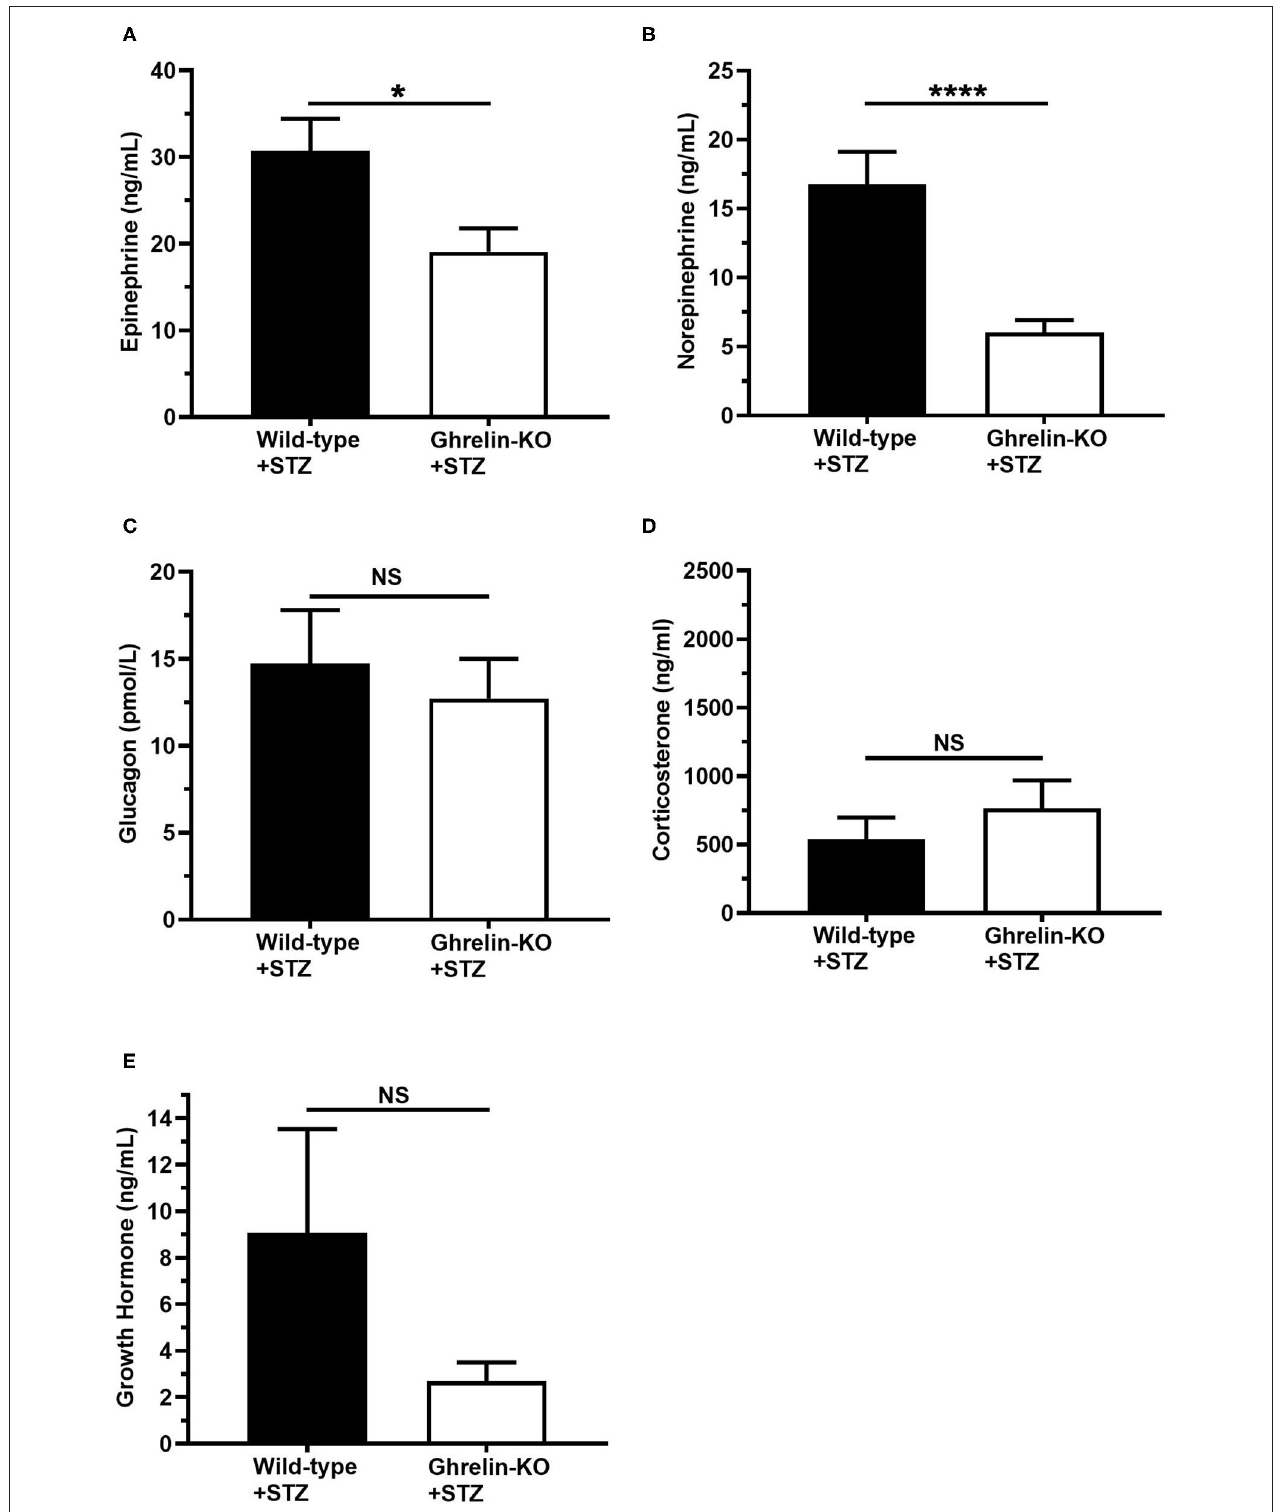
FIGURE 3 | Effects of ghrelin deletion on plasma CRR hormone levels obtained at the end of the hyperinsulinemic-hypoglycemic clamps. Plasma levels of (A) epinephrine, (B) norepinephrine, (C) glucagon, (D) corticosterone, and (E) GH at the end of the clamps ( t = 120min). n = 10–11. Data are presented as mean ± SEM. * P < 0.05, **** P < 0.0001, NS, no significant difference.